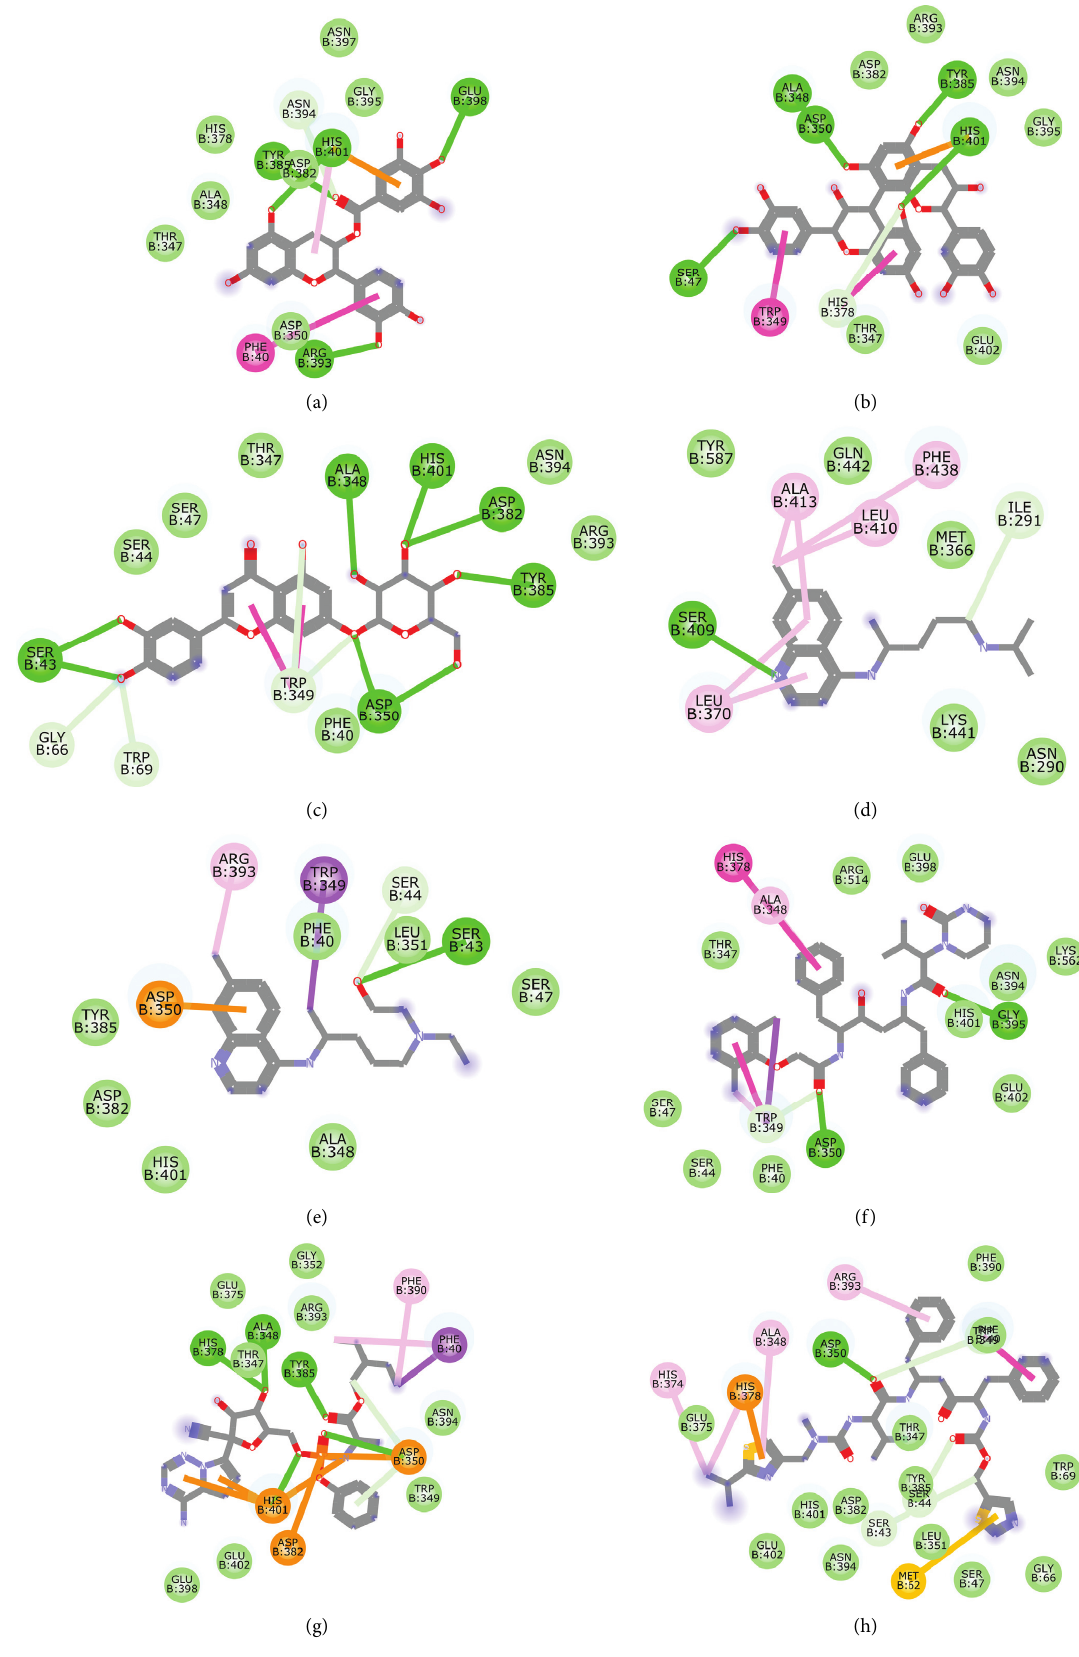
Figure 13: 2D representation of (a) 3-galloylcatechin, (b) proanthocyanidin B1, (c) luteolin 7-galactoside, (d) chloroquine, (e) hydroxy- chloroquine, (f) lopinavir, (g) remdesivir, and (h) ritonavir in the binding pocket of ACE2. Hydrogen and π bonds are depicted as green and any other coloured (purple, magenta, orange, turquoise blue, pink, and yellow) lines, while Van der Waal interactions appear as light green